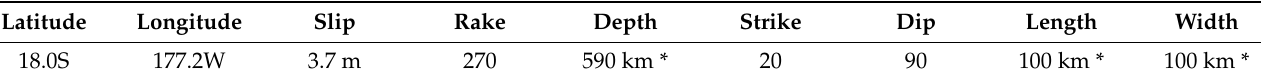
Table 1. The fault